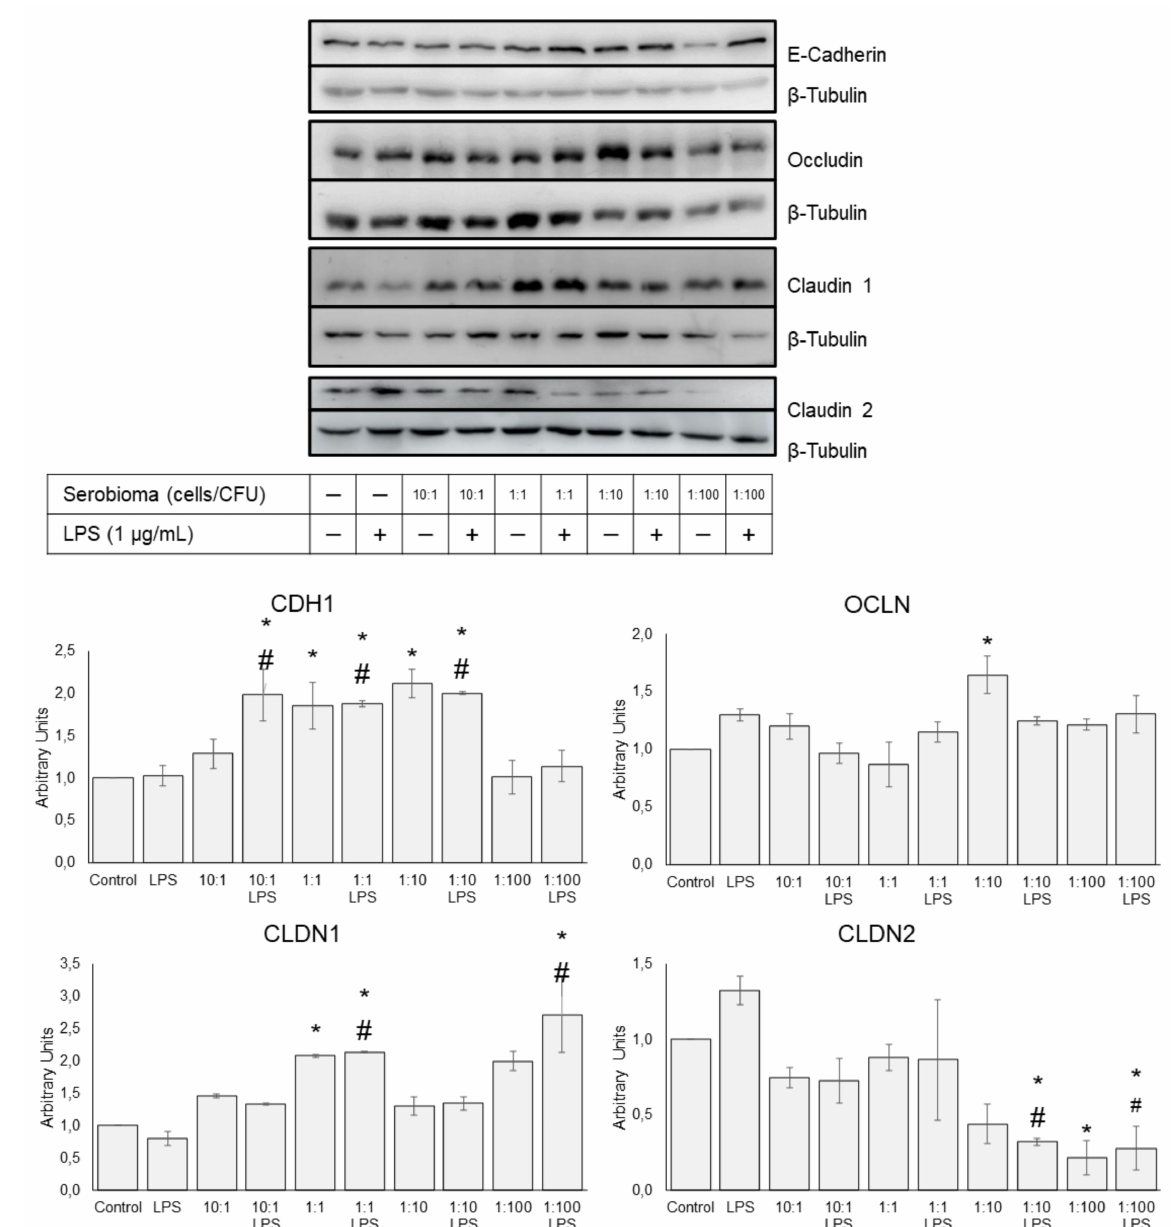
Figure 4. Western blot membranes and results for CADH1, OCLN, CLDN1, and CLDN2 proteins in Caco-2 cells challenged using four different cell/colony-forming unit (CFU) ratios (i.e., 10:1, 1:1, 1:10, and 1:100) for 24 h, in the absence of or in combination with an inflammatory stimulus (i.e., LPS at 1 µ g/mL concentration) introduced 4 h after probiotic exposure. The western blot signals were normalized using β -tubulin as the loading control. Results are expressed as mean ± SEM of the protein variation relative to the untreated sample. Statistical analysis: one-way ANOVA followed by Dunnett’s post hoc. * p -value < 0.05 with respect to the untreated control. # p -value < 0.05 with respect to the LPS-treated